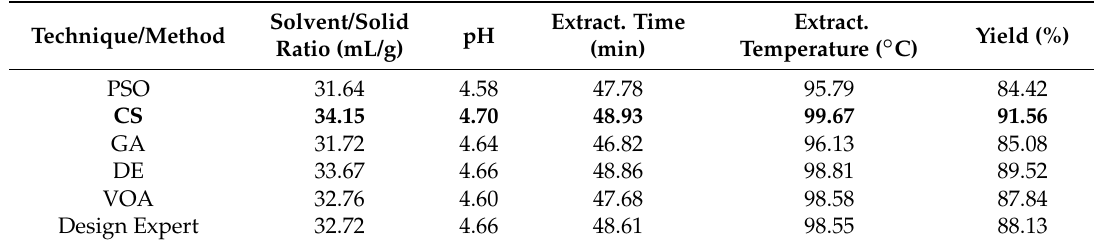
Table 5. The optimum conditions for the boric acid extraction from tincal (by considering different intelligent optimization algorithms and also Design